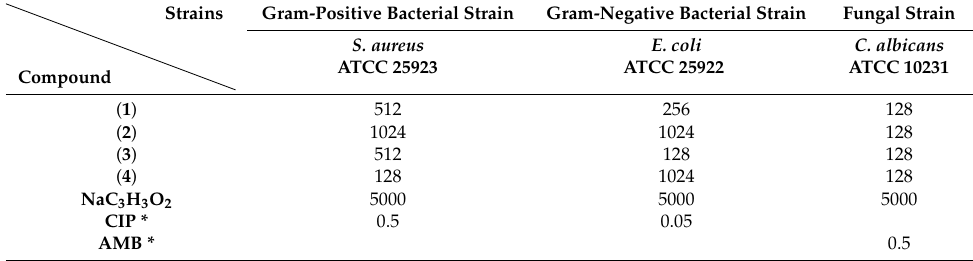
Table 6. Minimum inhibitory concentration ( µ g mL − 1 ) values recorded for complexes ( 1 )–( 4 ), sodium acrylate, and standard